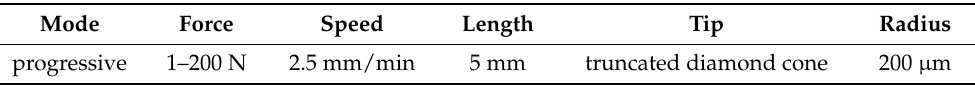
Table 2. Scratch test